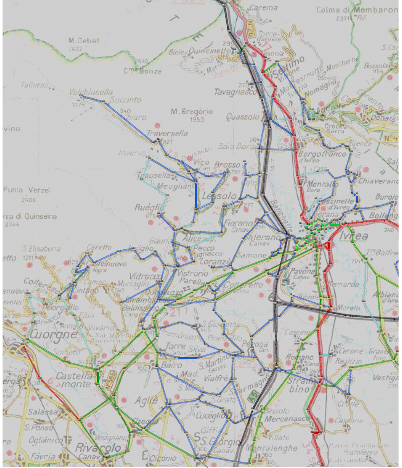
Figure 2. Road network used in experimental